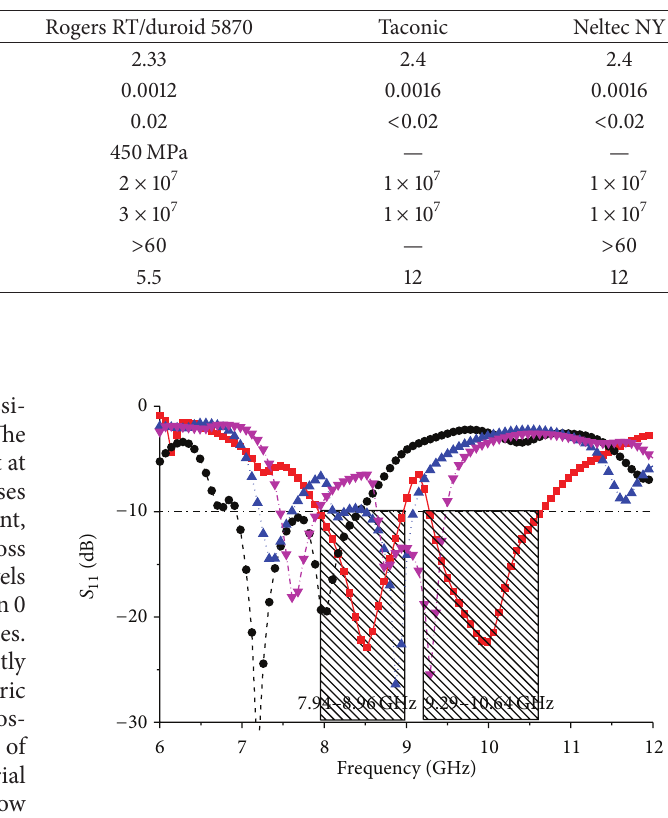
Table 1: Properties of different substrates ∗ .